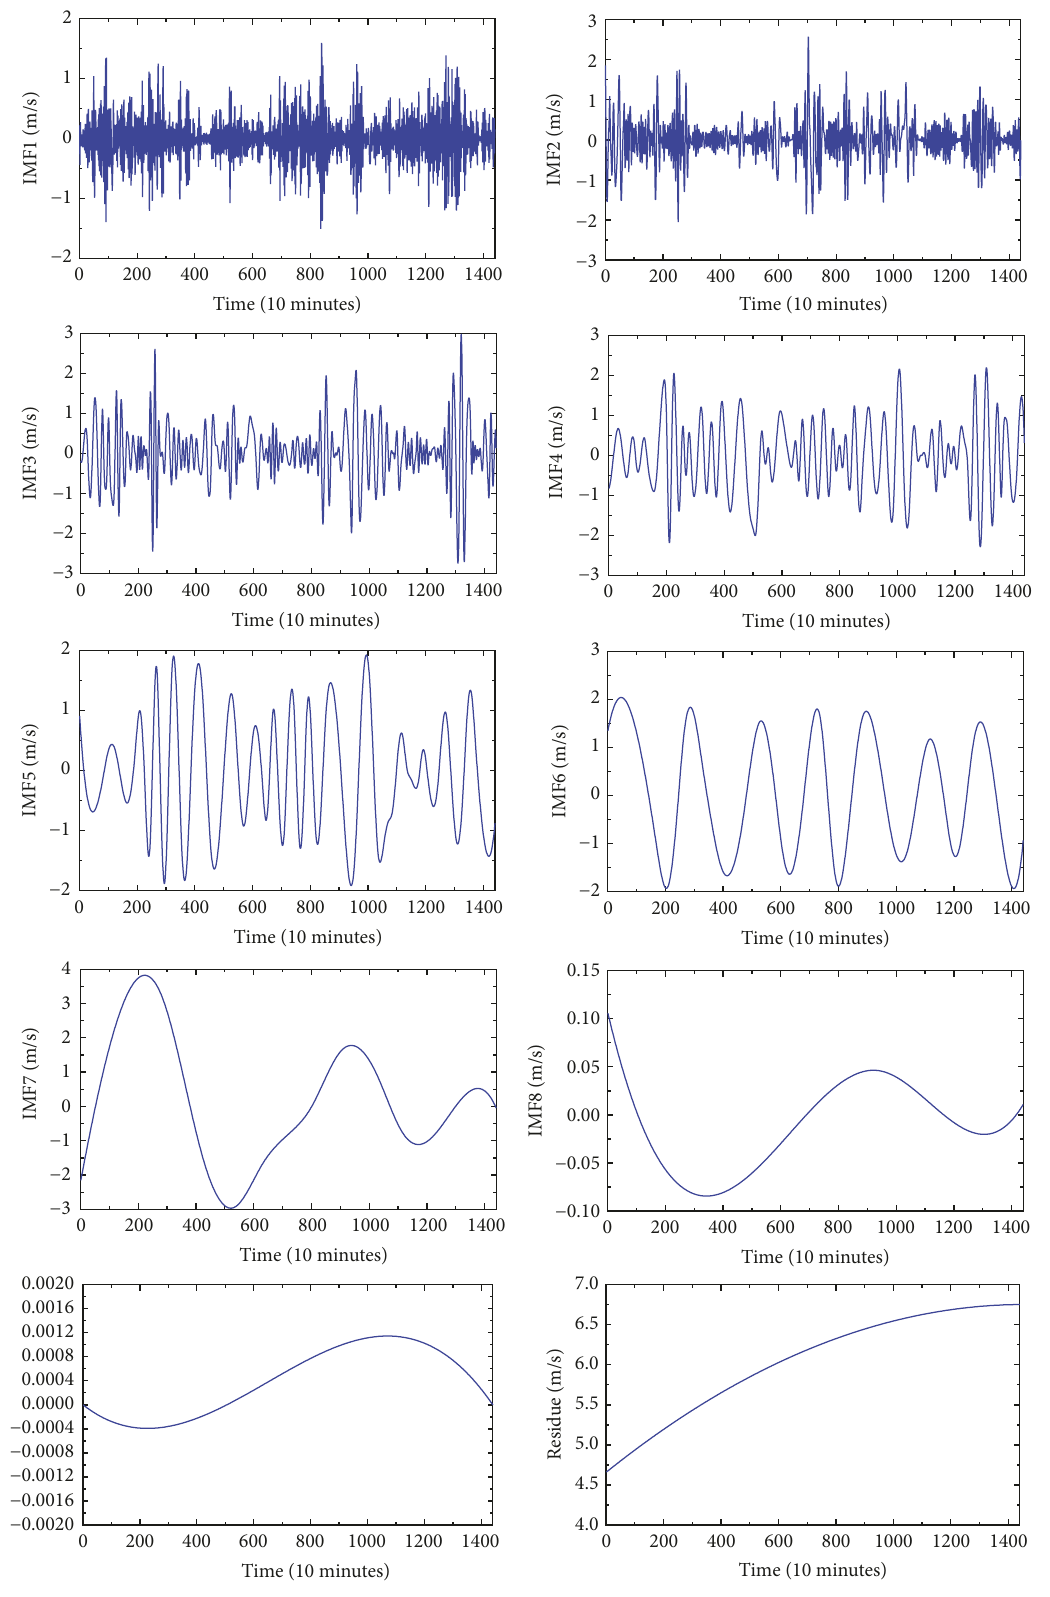
Figure 4: EEMD decomposition results of wind speed series (Case